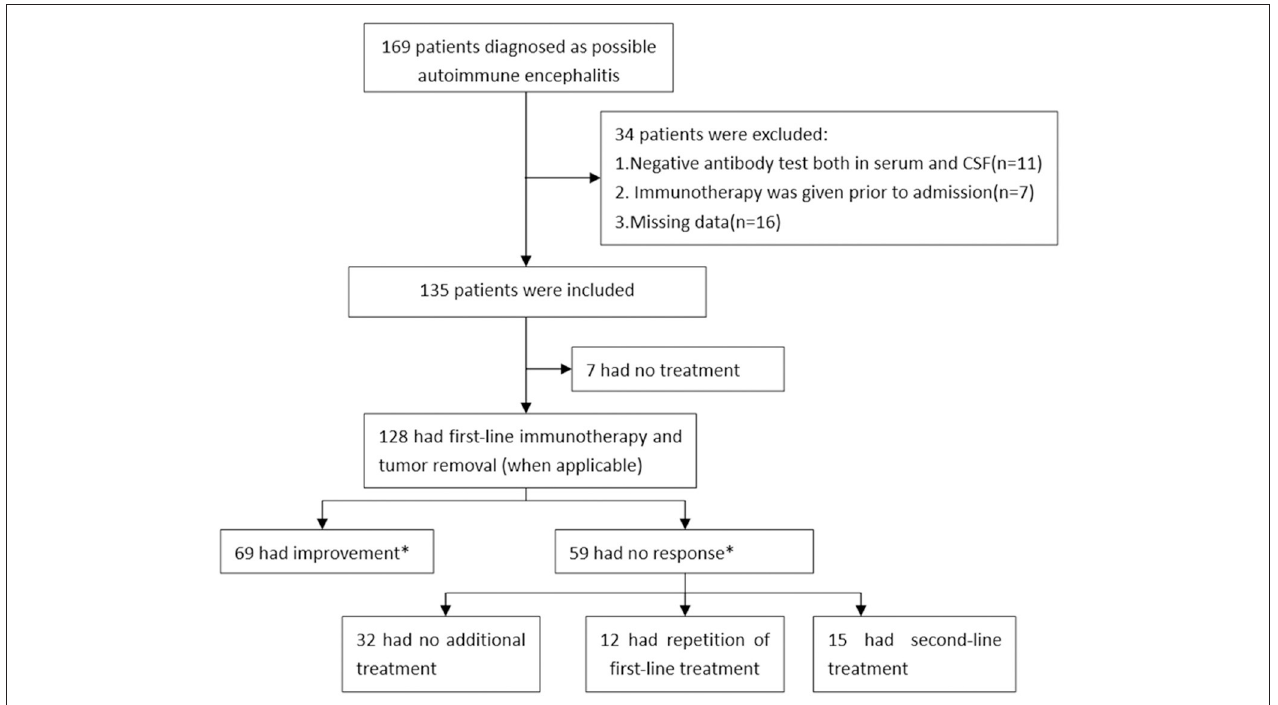
FIGURE 1 | Study profile in autoimmune encephalitis patients. *The occurrence of improvement was assessed at 10–14 days from initiation of first-line treatment.